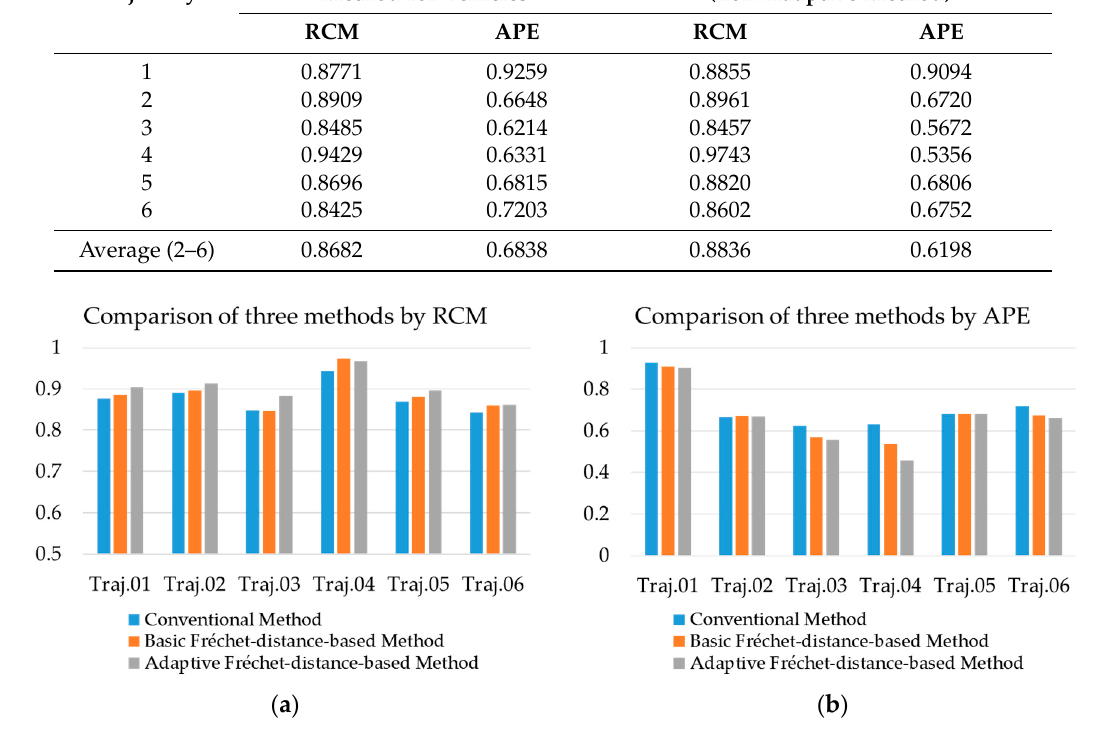
Figure 15. Comparison of performances of three map-matching methods–Conventional, Basic, and Adaptive Fréchet-distance-based method: ( a ) Comparison by RCM; ( b ) comparison by APE.